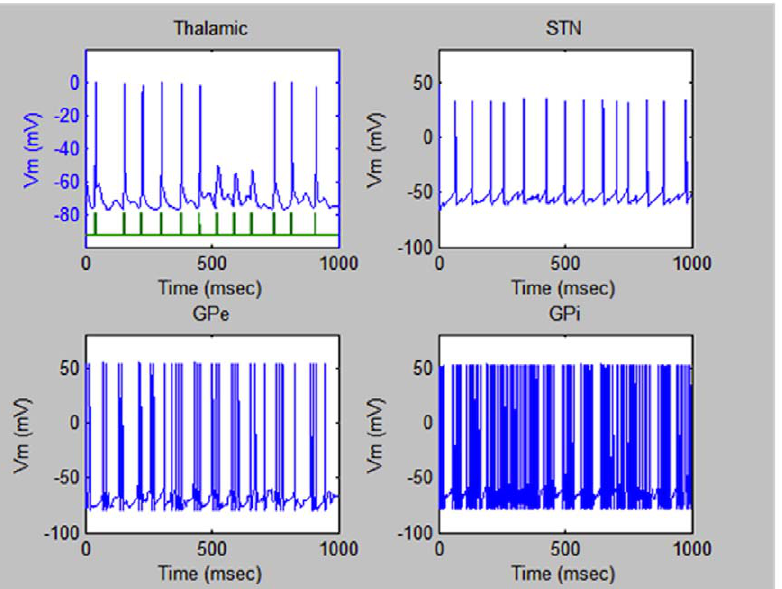
Figure 3. Electric pulses in the brain of a patient with Parkinson’s Disease. Typical electric pulsed sequences triggered in the four regions of the brain under study of a patient suffering from Parkinson’s Disease before the treatment by the ME nanoparticles.